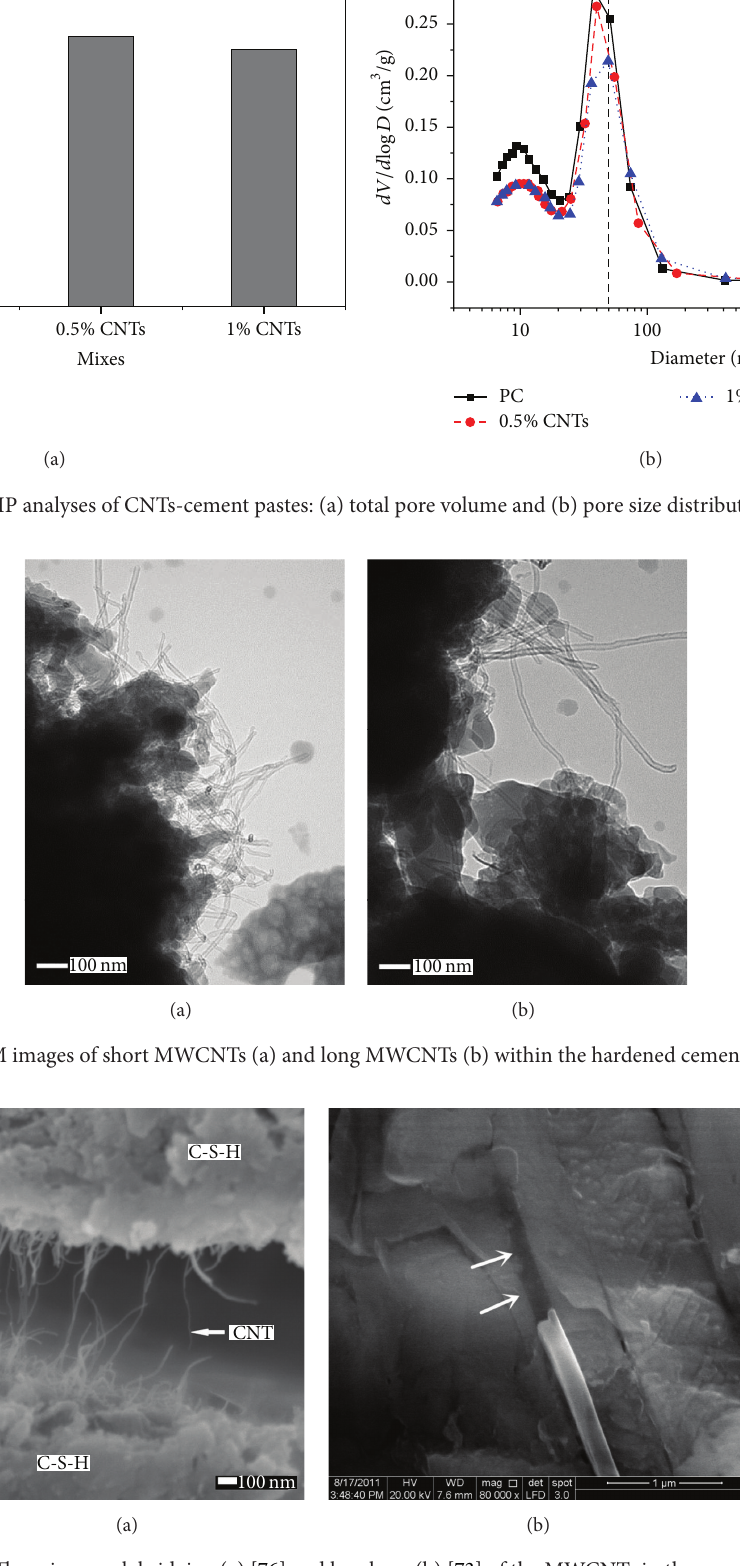
Figure 10: The microcrack bridging (a) [76] and breakage (b) [73] of the MWCNTs in the cement